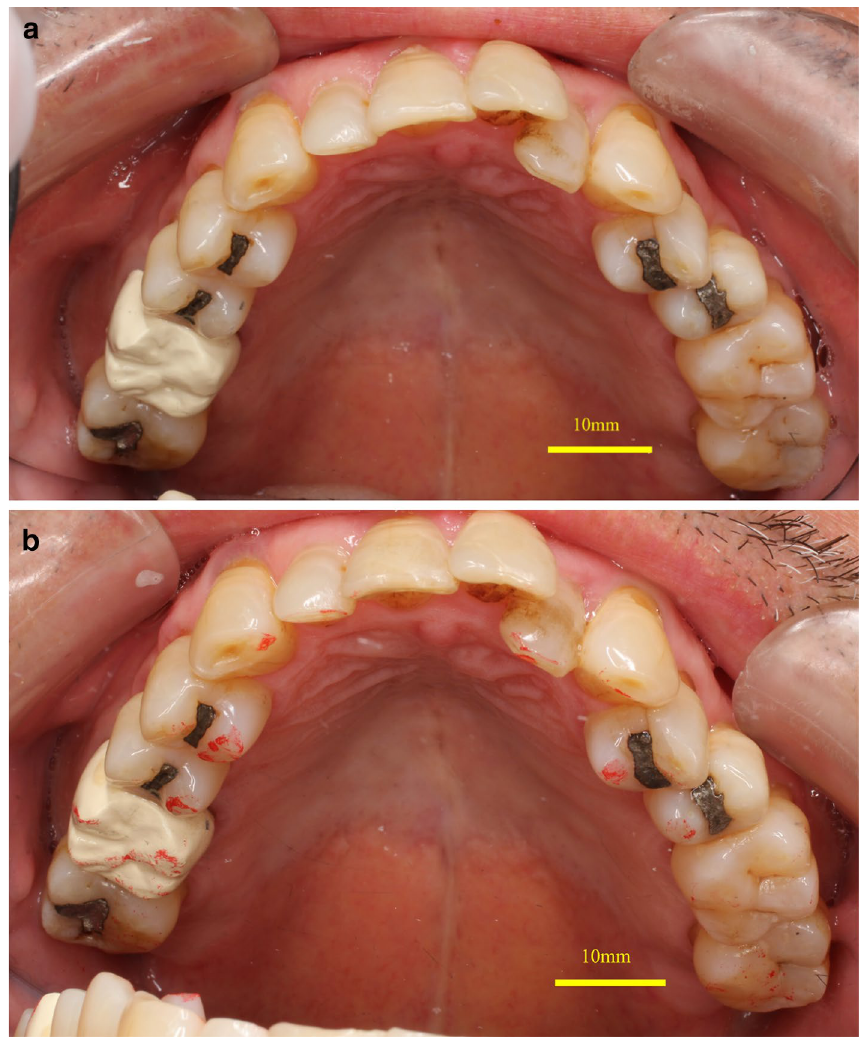
Figure 3. ( a ) Photographic image of an intraorally cemented polyetheretherketone crown on an upper right first molar at the time of cementing. ( b ) Photographic image of an intraorally cemented polyetheretherketone crown on an upper right first molar after six months of